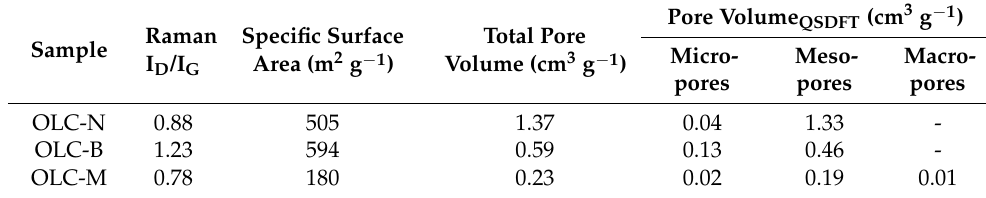
Table 1. Summary of Raman, surface area, and pore volume details of OLC samples obtained by Raman spectroscopy and N 2 physisorption